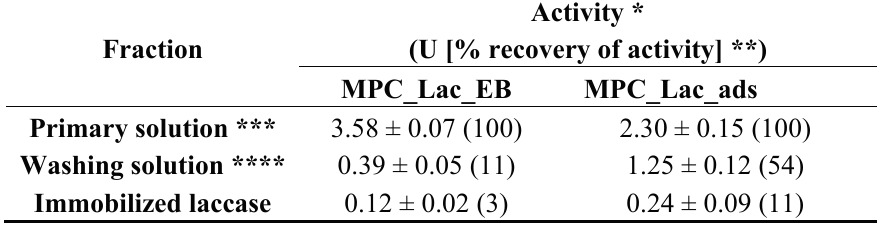
Table 3. Distribution of laccase activity within different fractions resulting from laccase immobilization using cryogels.